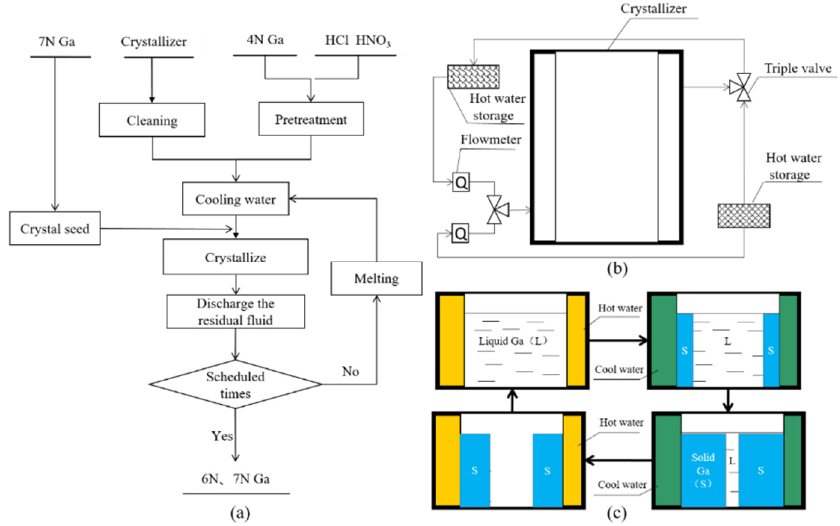
Figure 1. Schematic diagram of the purification process: ( a ) Process flow for purification, ( b ) assembly of the purification device, and ( c ) repeated crystallization process.